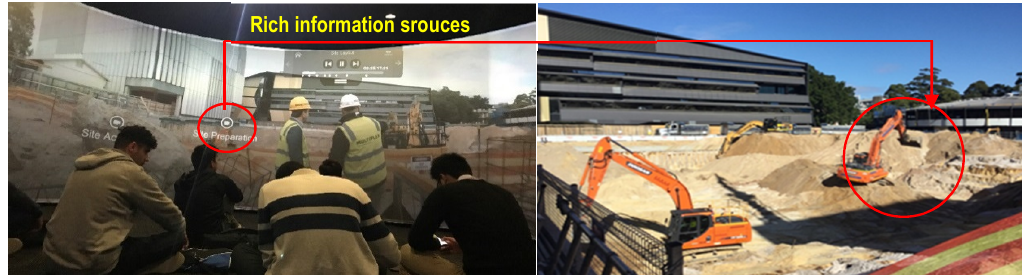
Figure 8. The immersive environment used for the case course at the University of New South Wales (UNSW) (right), A selected Hotspot Site Layout Interview—Bulk excavation (left), the produced module, including the hot spots linked to rich information for each topic.